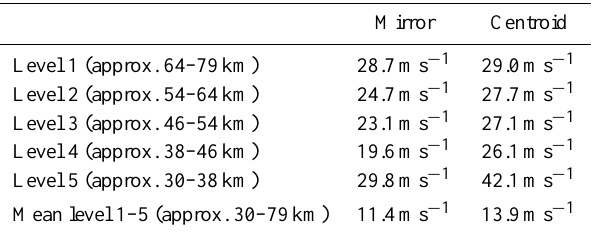
Table 2. Error in the retrieved daily average wind for a noise level of 0.23K per channel on both daily average spectra. The underlying ozone profile corresponds to a mid-latitutde winter standard atmo- sphere.